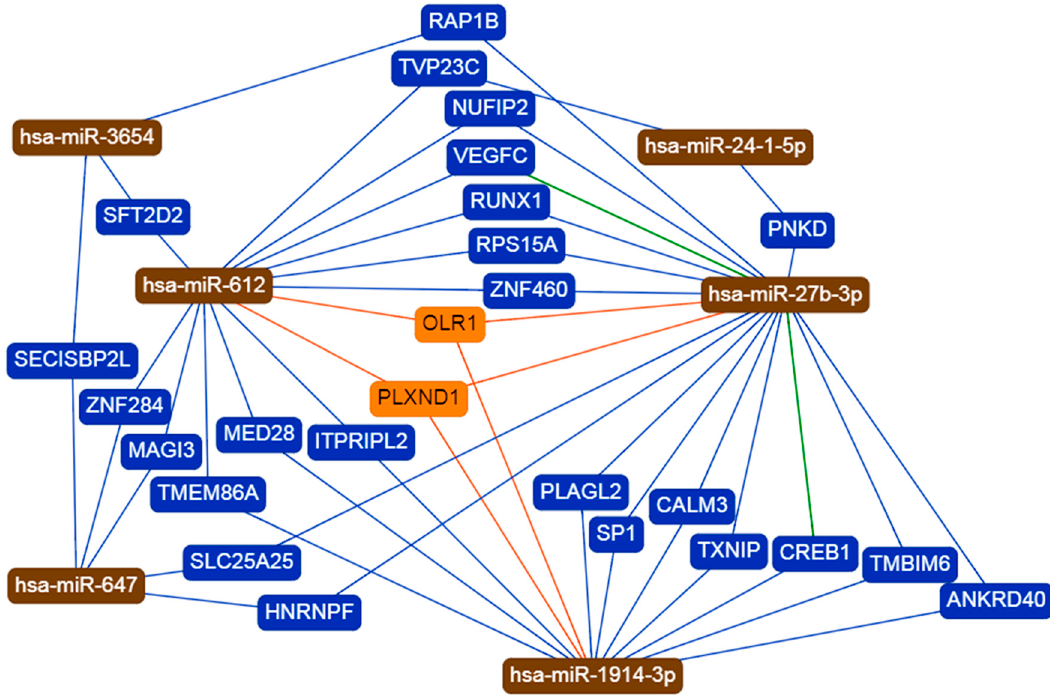
Figure 2. Target gene overlaps between 6 miRNAs. A total of 26 genes are targeted by two or more of the miRNAs. hsa-miR-612 showed 14 interactions, hsa-miR-647 shared 5 interactions, hsa-miR-3654 displayed 3 interactions, hsa-miR-1914-3p shared 12 interactions, hsa-miR-24-1-5p had 2 interactions, and hsa-miR-27b-3p showed 18 interactions. Blue and orange lines indicate weak evidence, while green lines showed strong evidence.